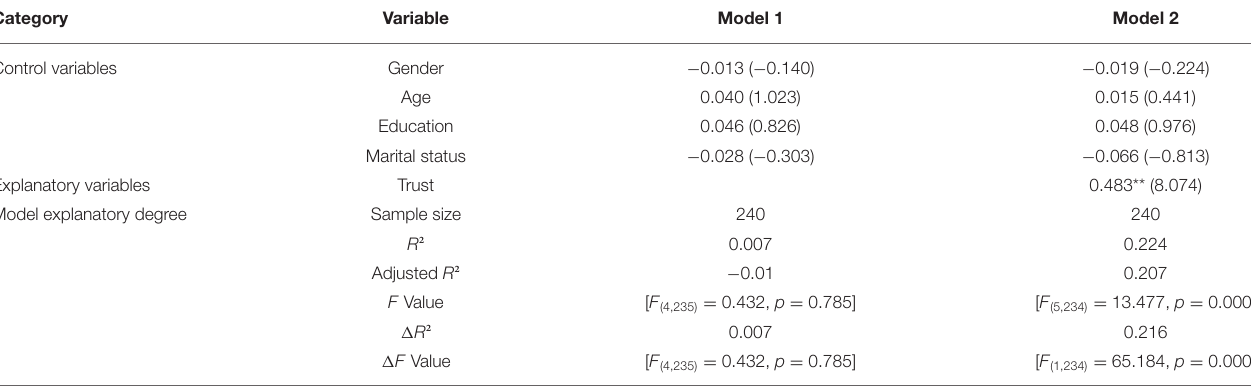
TABLE 7 | Multilevel regression test results (Explanatory variable: AVA).